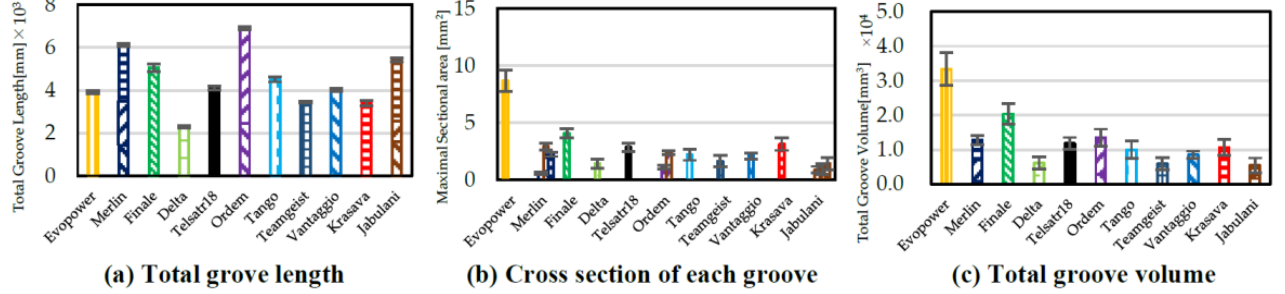
Figure 7. Specifications of ball groove: (a) Total groove length, (b) Cross section of each groove, and (c) Total groove volume.